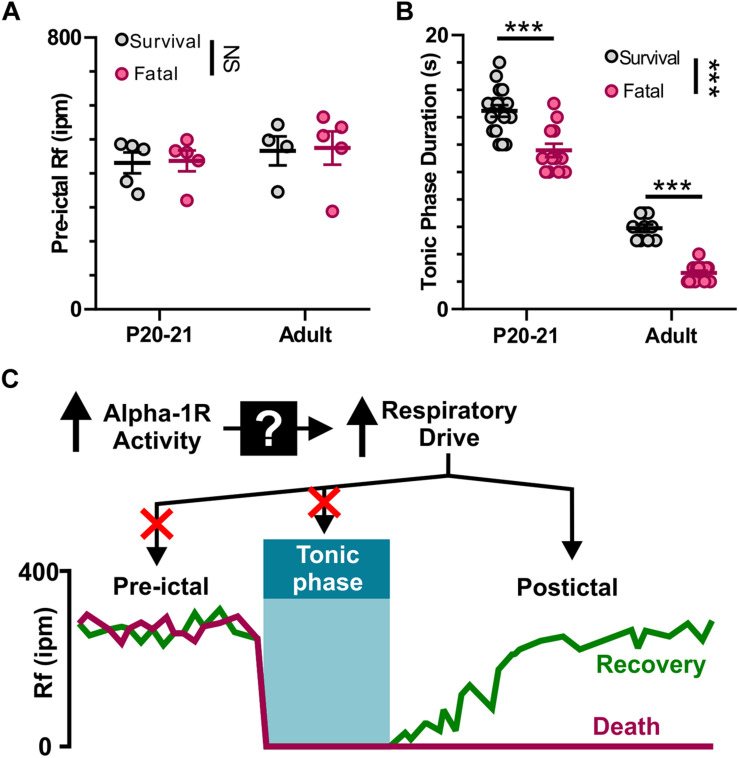
Neither pre-ictal breathing rate nor extended duration of tonic phase cause seizure-induced death. (A) Pre-ictal breathing rates in survival (gray) and fatal seizures (pink) in both P20-21 and adult D/+ mice. (B) Tonic phase duration in P20-21 and adult D/+ mice for both survival and fatal seizures. (C) Graphic summary: At the onset of tonic phase of seizures, breathing stops. Recovery of breathing from this apnea determines whether or not the animal recovers and survives. Mechanistically, alpha-1 receptors function upstream to drive respiration and prevent seizure-induced death. ***, NS indicate P < 0.001, and > 0.2, respectively, for main effect of survival vs. fatal and post hoc comparisons between age groups.